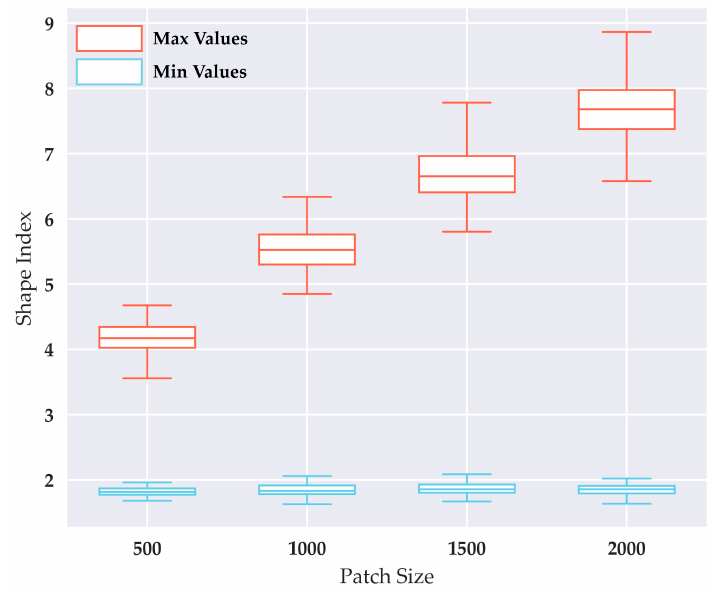
Figure 12. The distribution of maximum and minimum shape index values from 100 tests with a constant patch size.